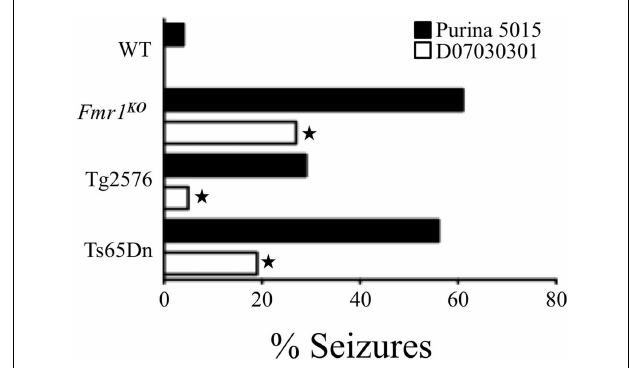
FIGURE 1 | Soy-free diet reduces seizure propensity in several strains of mice including Fmr1 KO (FXS mouse model that lacks FMRP expression),Tg2576 (Alzheimer’s disease mouse model that over-expresses the human APP 695 gene with the Swedish familial mutation), andTs65Dn (Down syndrome mouse model that is trisomic for chromosome 16 carrying the App gene) (38) .These mouse models of neurological disease andWT littermates were conceived and maintained on soy-based Purina 5015 chow. At age P18, pups were left on the Purina 5015 (black bars) or transferred to a purified ingredient, soy-free diet (D07030301, white bars) for 3days prior to seizure testing. Statistical significance between mice of the same genotype but fed different diets was determined by Barnard’s exact test (two-tail) and is denoted by a star ( P ≤ 0.05).